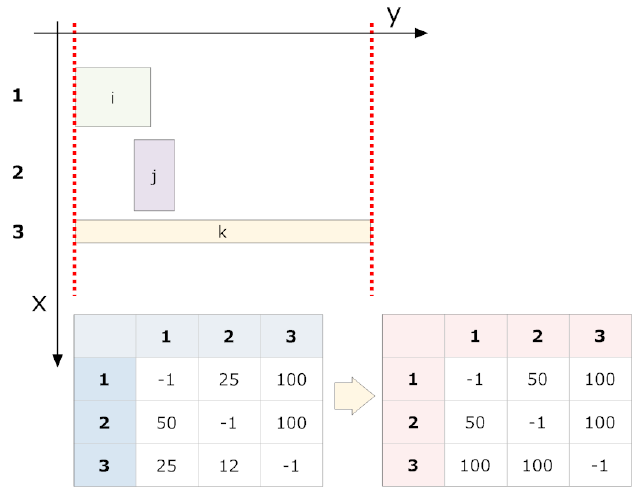
Figure 18. Schematic of a grouping. We proceed based on three groups: (1)–(3). Each group contains a single fragment. The first cycle of grouping starts on the left. Based on the overlap table, a simplified version is generated where only the maximum magnitudes are listed (this table is symmetric). In this example, the scan order is from top to bottom and left to right (it could be any order) so that (1) and (3) are first eligible for grouping. Therefore, (2) may not be grouped with either (1) or (3) because they have been grouped in this